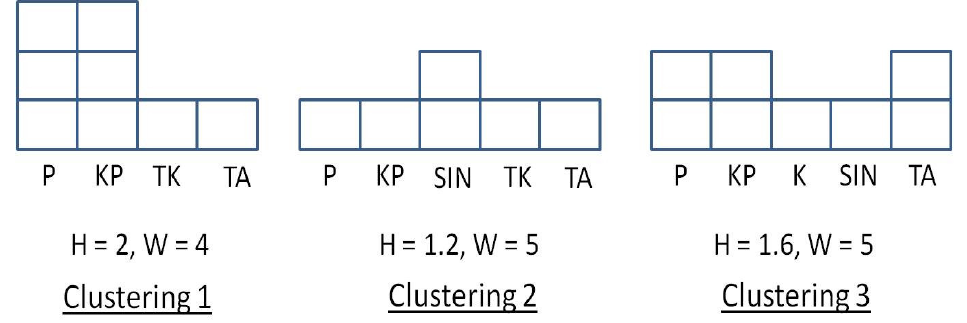
Figure 3. Three different clusterings, with height (H) and width (W) values.